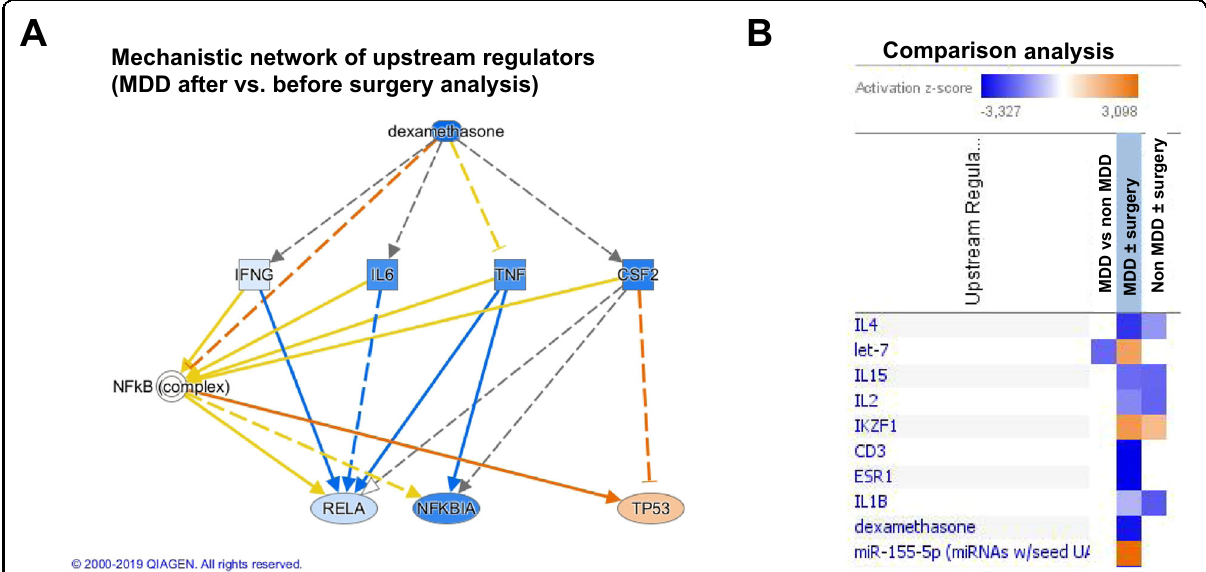
Fig. 2 Upstream regulator analyses using Ingenuity Pathway Analysis. A Mechanistic network connecting upstream regulators found in the differential expression analysis between MDD patients after versus before surgery. B Comparison analysis of upstream regulators in the three differential expression analyses. Upstream regulators are sorted by activation z-score with color code at the top of the fi